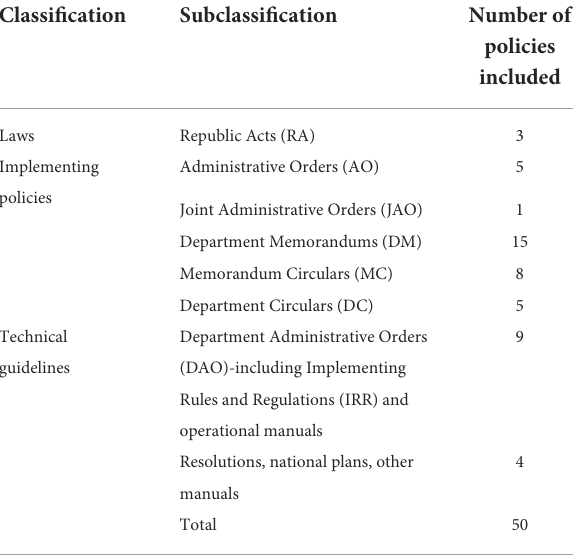
TABLE 1 Classification of policies analyzed in the